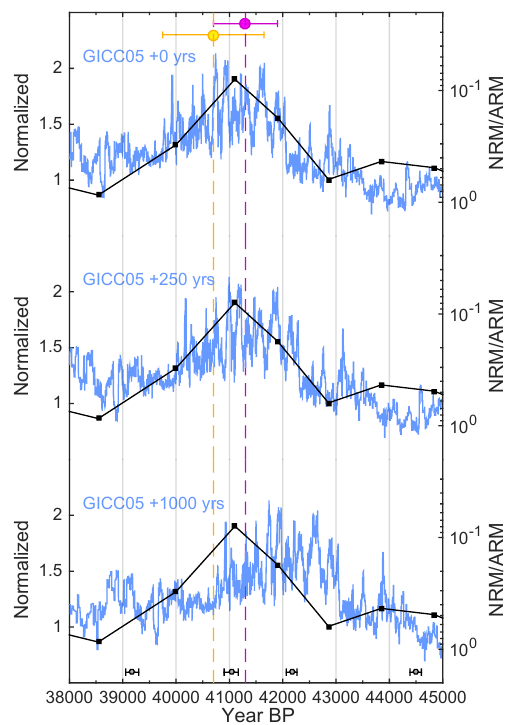
Figure 11. Comparison of the ice-core stack (blue) to Ar–Ar dates of the Laschamp excursion (yellow: Singer et al., 2009; pink: Laj et al., 2014) and relative geomagnetic field intensity (black; NRM/ARM; reversed y axis) from a U / Th-dated speleothem (Lascu et al., 2016). The individual speleothem U / Th dates are shown on the bottom of the figure with their ± 2 σ uncertainties. Each panel shows a different shift of GICC05 according to the re- sults from Fig.